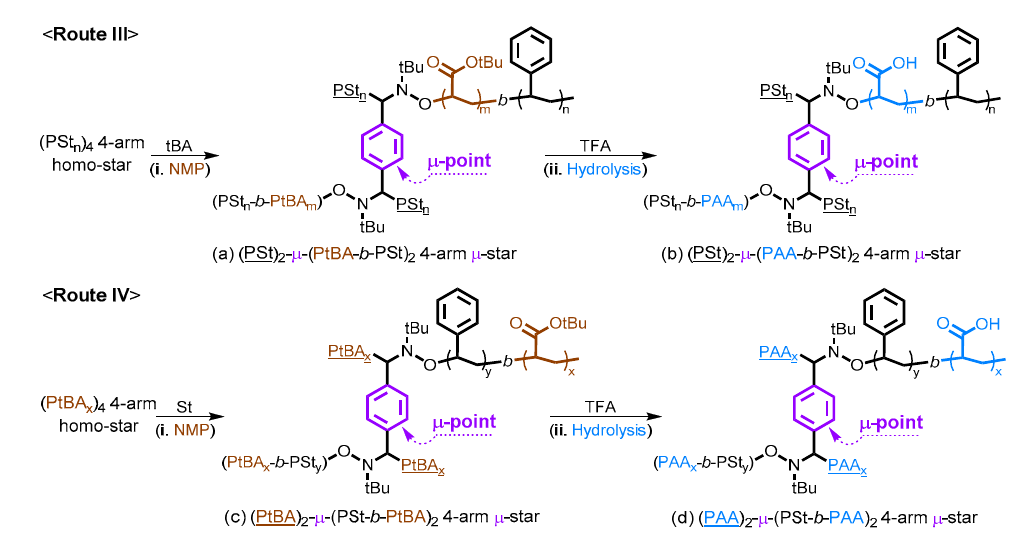
Scheme 2. Synthetic routes of miktoarm star ( µ -star) copolymers to obtain ( a ) (PSt) 2 - µ -(PtBA-b-PSt) 2 , ( b ) (PSt) 2 - µ -(PAA-b- PSt) 2 , ( c ) (PtBA) 2 - µ -(PSt-b-PtBA) 2 , and ( d ) (PAA) 2 - µ -(PSt-b-PAA) 2 .